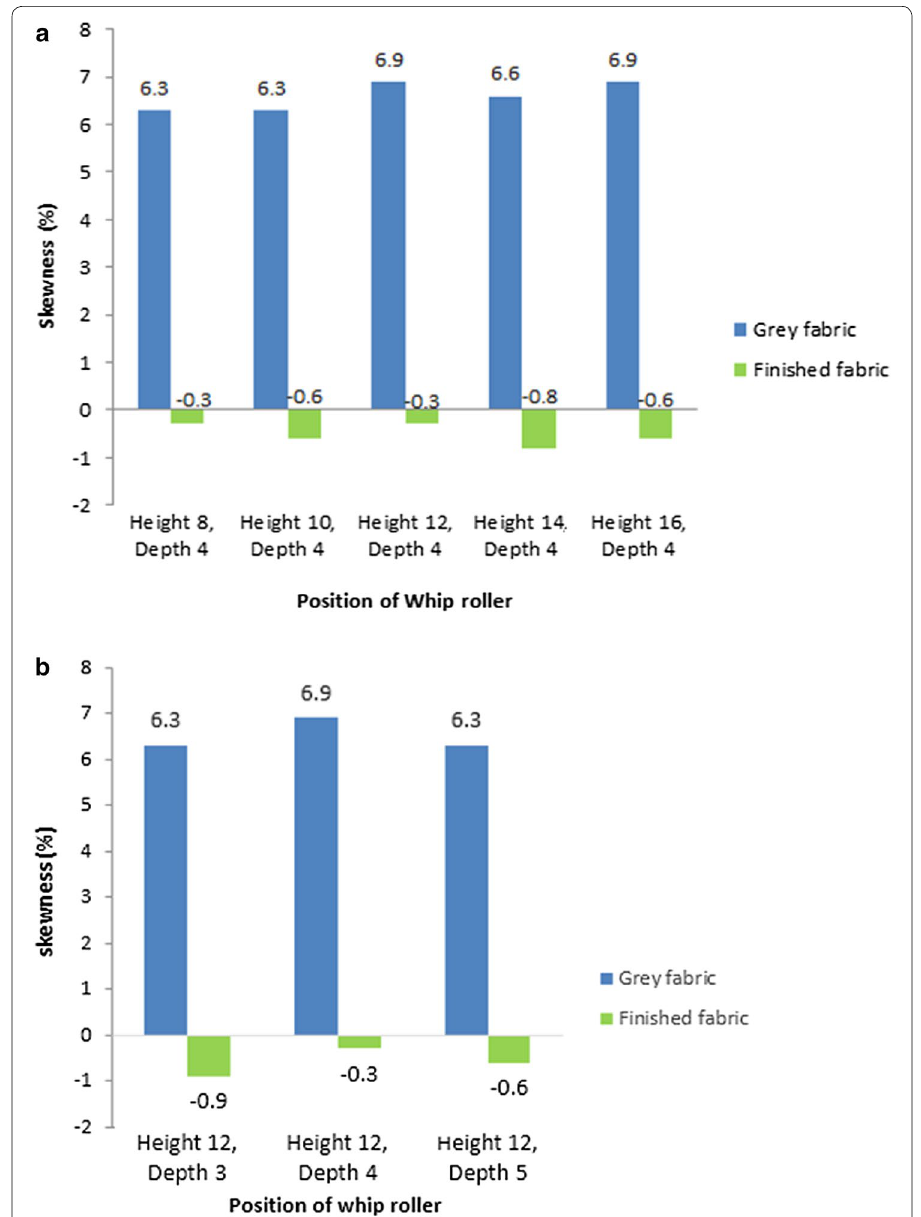
Fig. 13 a Skewness (%) at variable height and constant depth of whip roller. b Skewness (%) at constant height and variable depth of whip